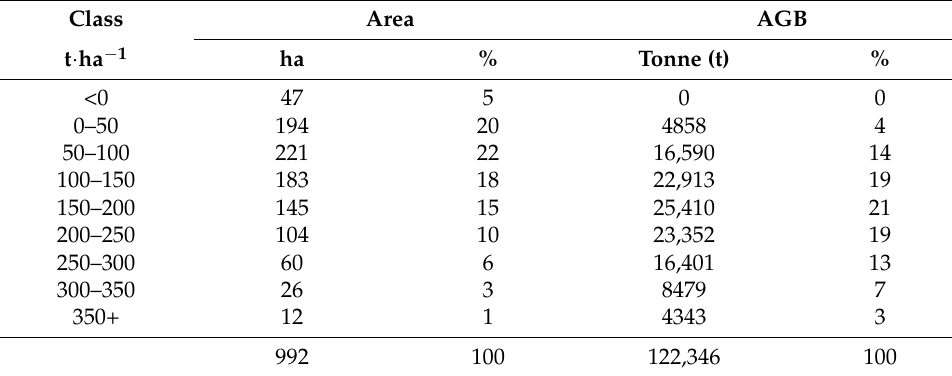
Table 8. Biomass estimation in Viglas according to MR2 model.